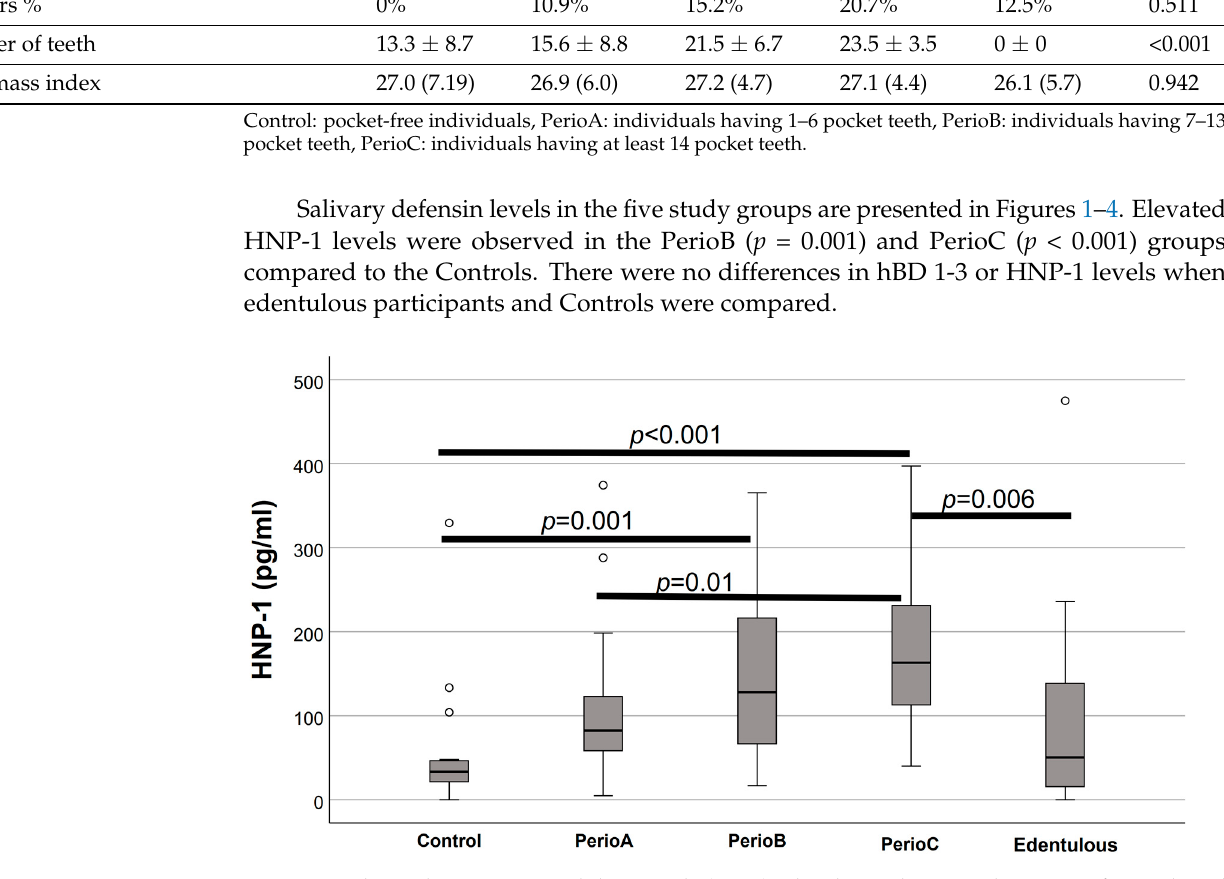
Figure 3. Salivary human β -defensin (hBD)-2 levels in relation to the extent of periodontal destruc- tion (empty circles indicate outliers). No significant differences were found between the groups.